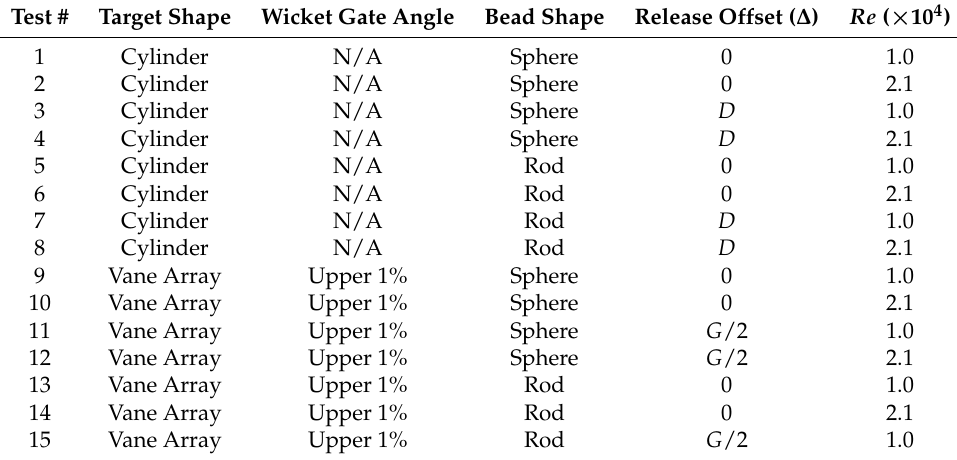
Table 1. Experimental test